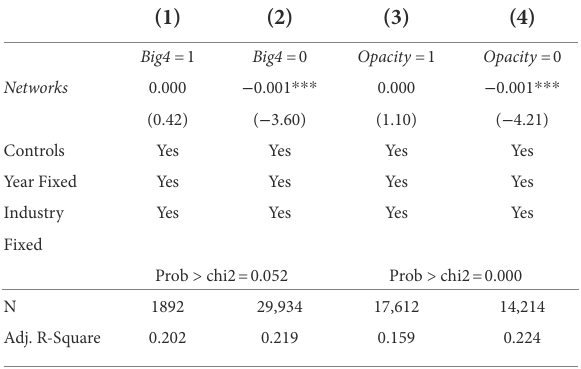
TABLE 8 Cross-sectional